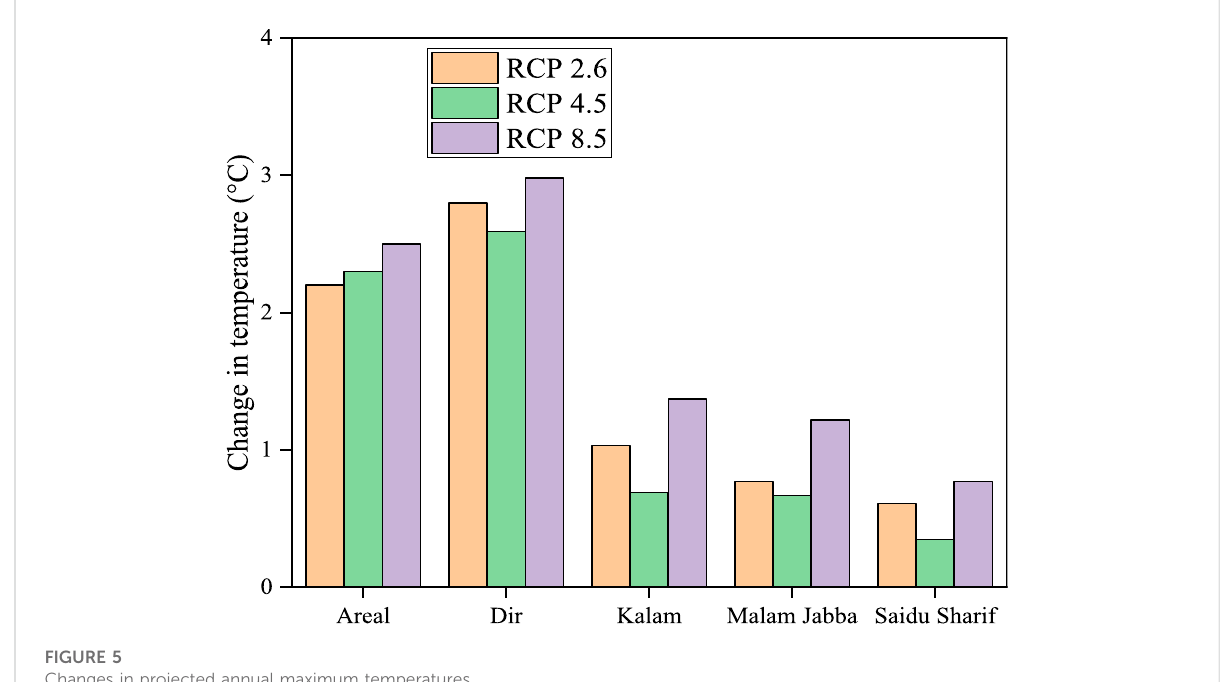
FIGURE 5 Changes in projected annual maximum temperatures.